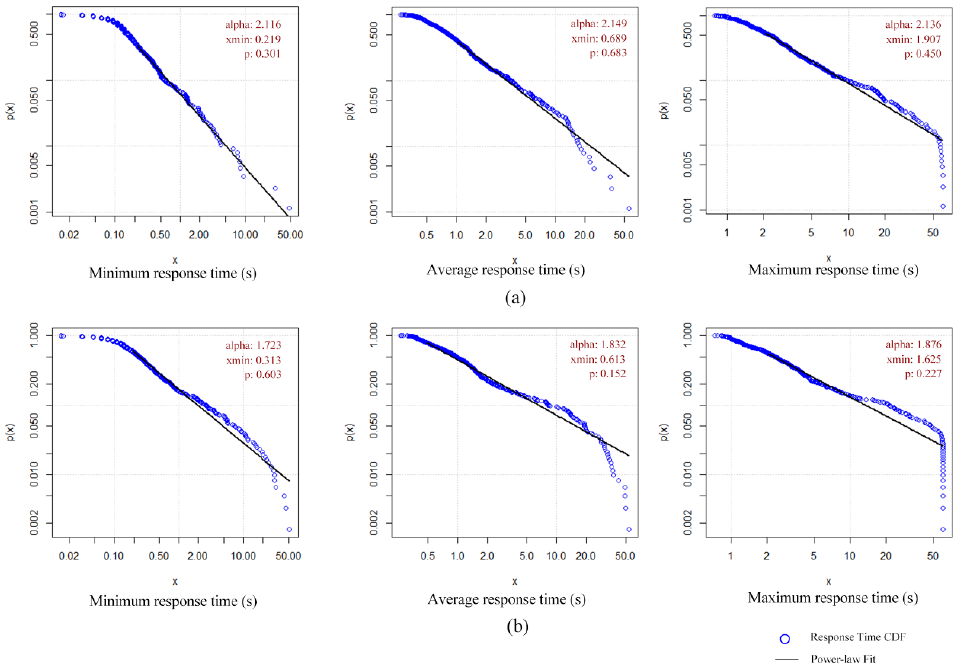
Figure 12. Log-log plot of the CDFs P(x) for minimum, average and maximum response times of ( a ) GetCapabilities operations and ( b ) GetMap operations for selected WMSs reflecting continuous